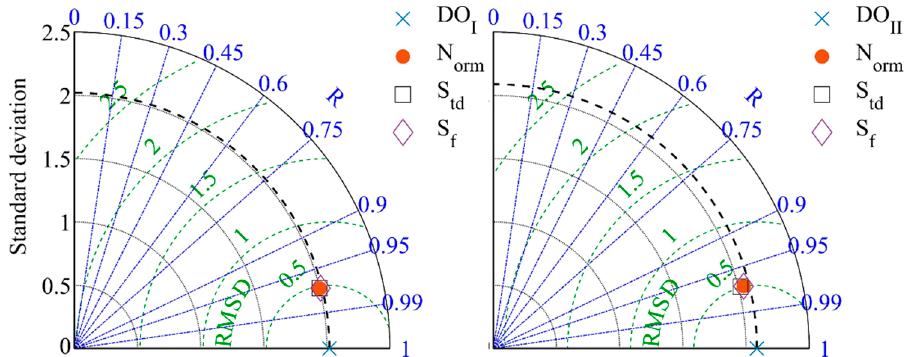
Table 5. Descriptive statistics of the forecasted DO data vs. the observations.